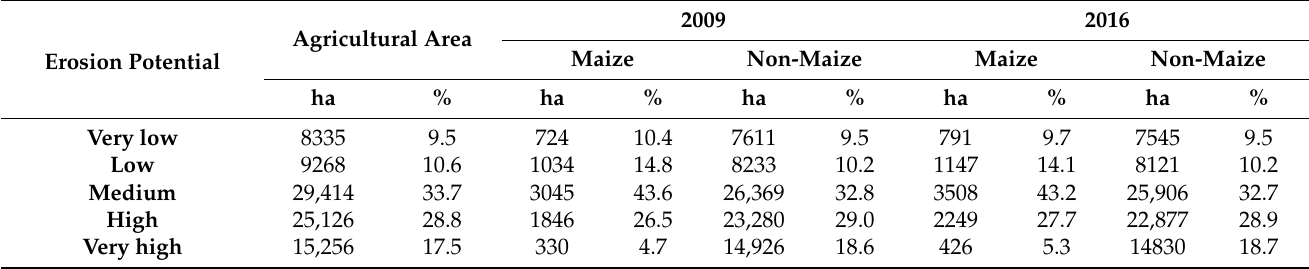
Figure 7. Map showing the calculated natural potential for soil erosion (E nat ) in the study area. Areas shown in white colour are non-agricultural sites and were thus excluded from erosion modeling. Table 6. Assignment of the total agricultural area as well as maize and non-maize (all agricultural soil uses except maize) cultivation in 2009 and 2016 to the classified natural soil erosion potential (E nat